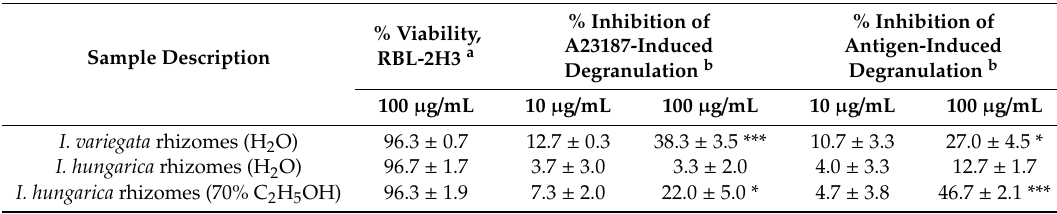
Table 8. Anti-allergic activity of Iris sp.